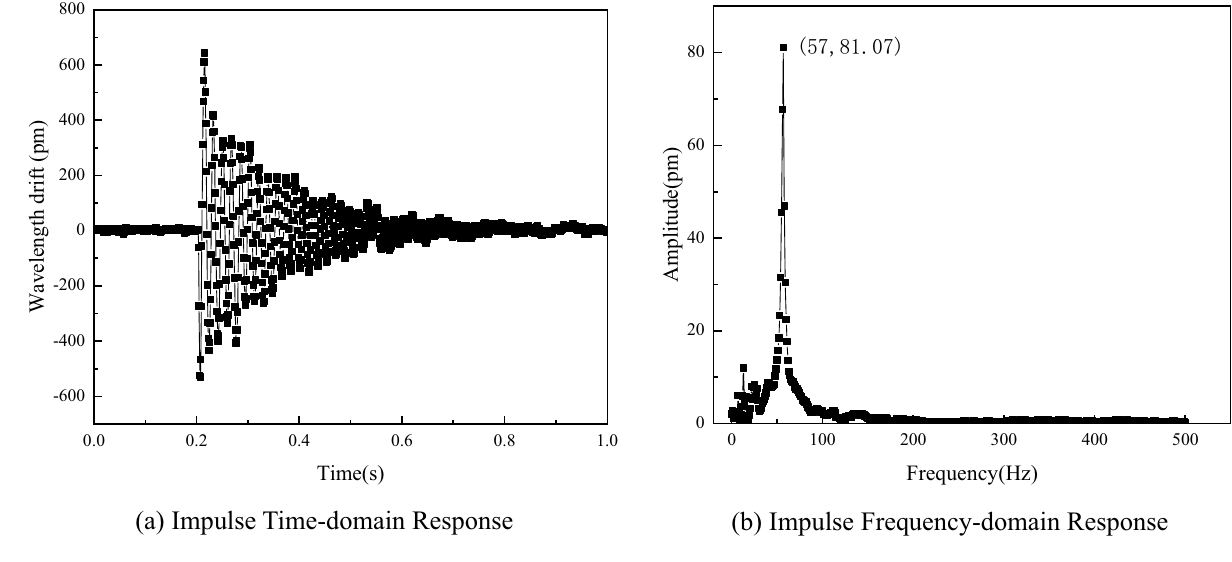
Figure 14. Impulse response curve.